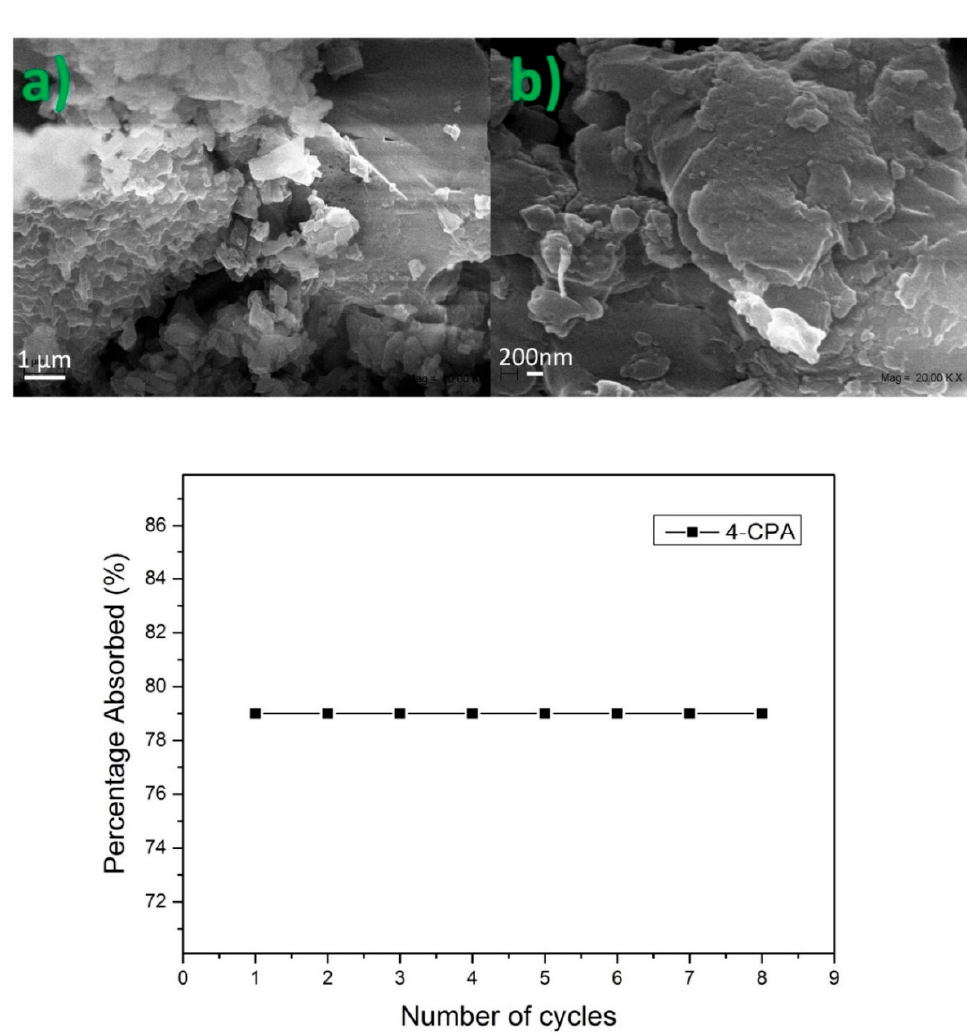
Figure 9. SEM images of nanosponges (NS) after a repeated number of cycles ( a , b ). Percentage of 4-chlorophenoxyacetic acid (4-CPA) adsorbed after a repeated number of cycles.